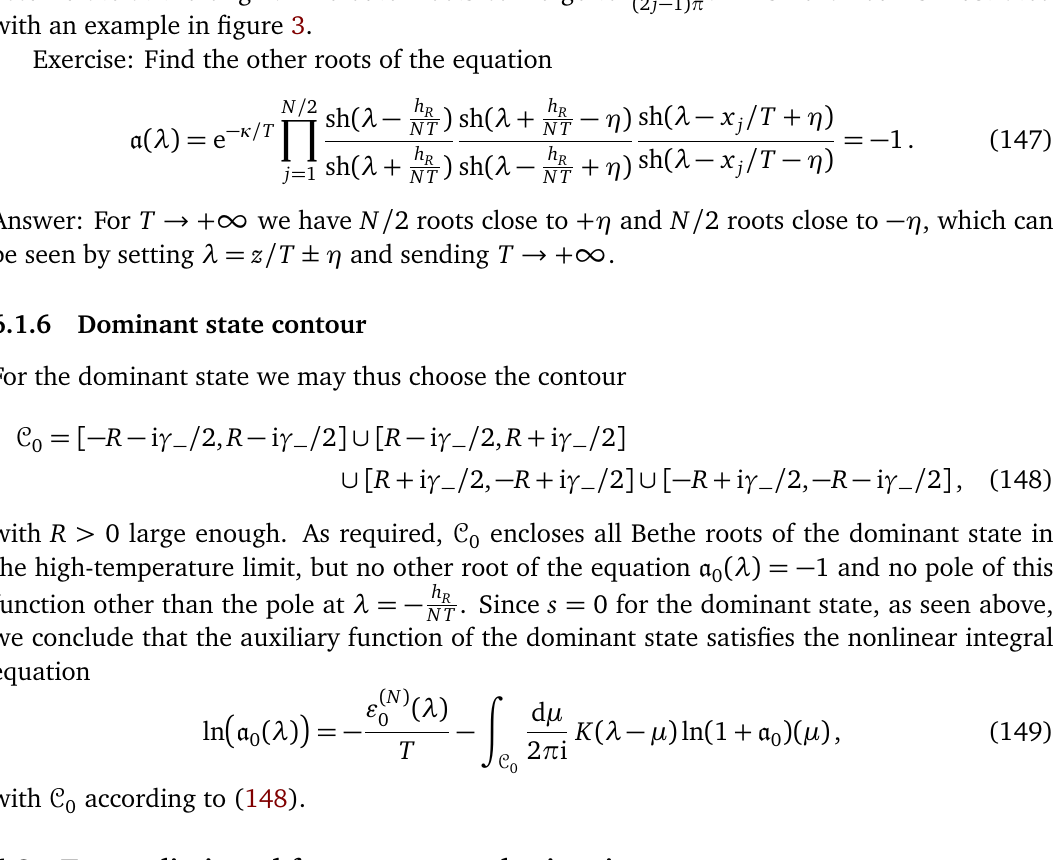
for N = 52, J = 1, γ = j